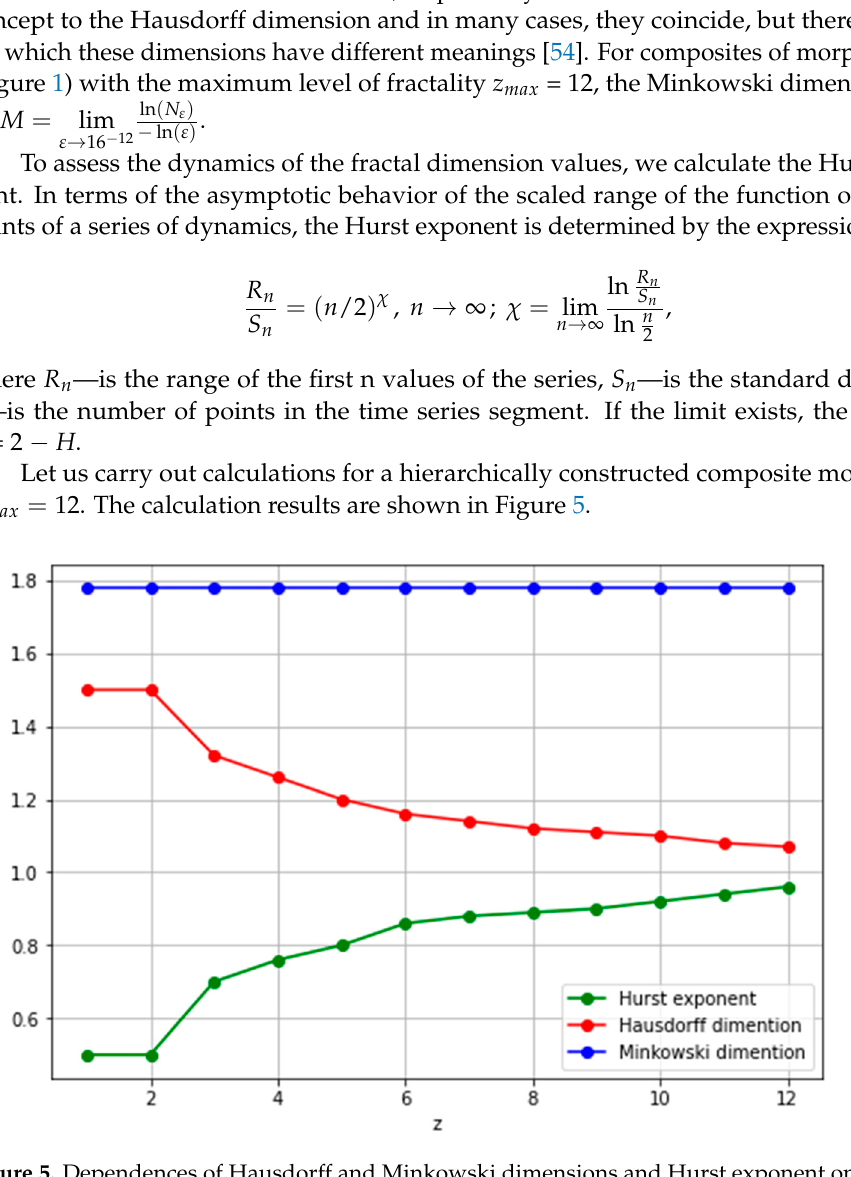
Figure 5. Dependences of Hausdorff and Minkowski dimensions and Hurst exponent on the level of fractality .